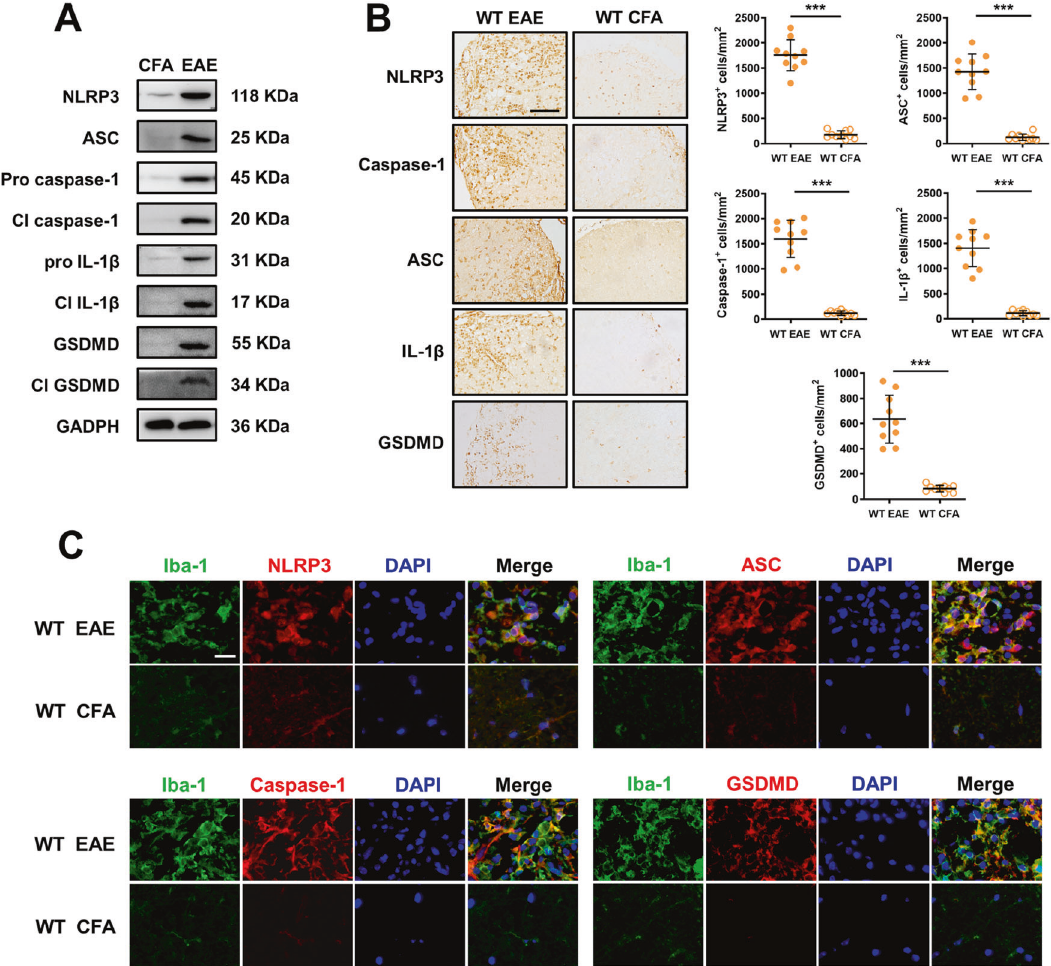
or CFA-treated mice on day 18 after treatment ( n = 10 per group). B Immunohistochemistry showing in fi ltration of NLRP3, ASC, caspase-1, IL- 1 β , and GSDMD-positive immune cells in the spinal cords of EAE-induced WT mice at peak disease or CFA-treated WT mice on day 18 after treatment. Scale bar: 50 µm. n = 10 per group. C Immuno fl uorescent labeling of Iba-1 (green), NLRP3, ASC, caspase-1, or GSDMD (red), and DAPI (blue) demonstrates the expression and process of NLRP3 in fl ammasome and GSDMD-mediated pyroptosis in the microglia of WT EAE mice at peak disease or CFA-treated WT mice on day 18 after treatment ( n = 10 per group). Scale bar: 20 µm. Data are from three representative independent experiments and were analyzed by an unpaired t -test or the Mann – Whitney U test. Error bars show the mean ± SEM. *** P <